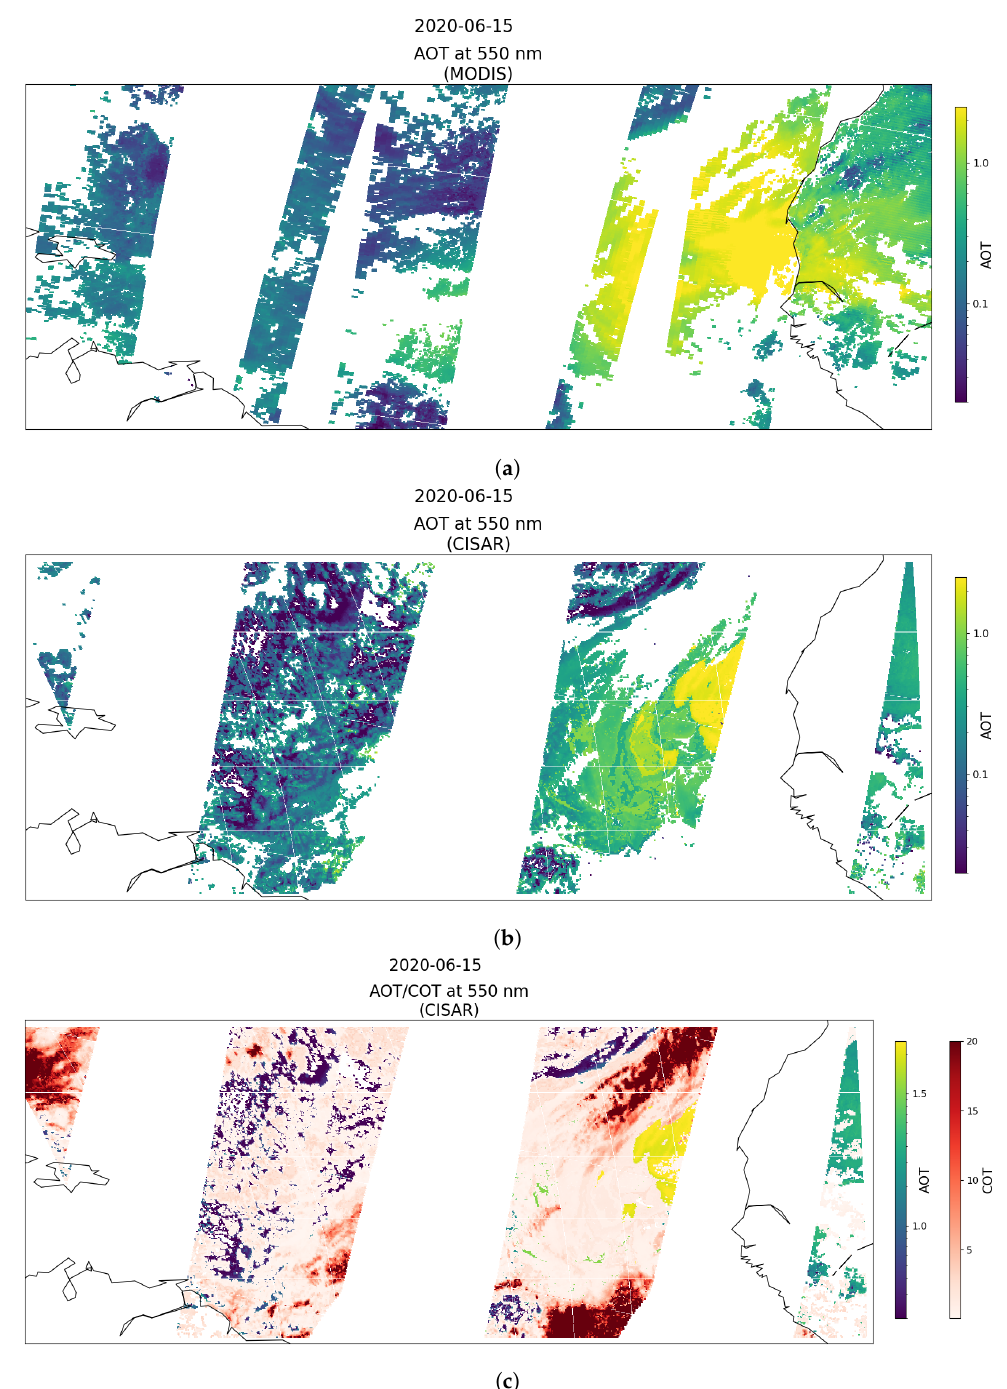
Figure 13. AOT at 0.55µm as retrieved by the combined Dark Target and Deep Blue algorithms applied to MODIS/Terra ( a ) and by CISAR ( b ). ( c ) CISAR combined AOT/COT product for all COT retrievals larger than